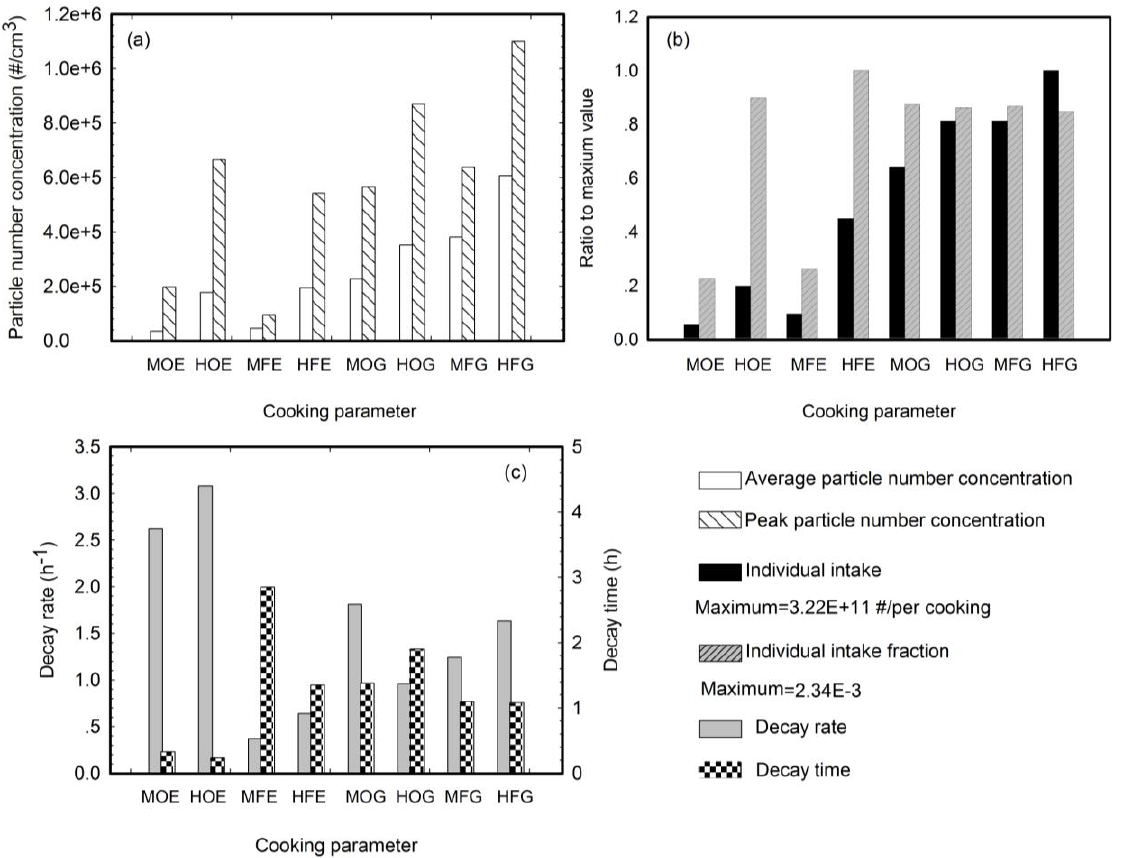
Figure 2. Effects of cooking parameters on (a) particle emission, (b) individual intake